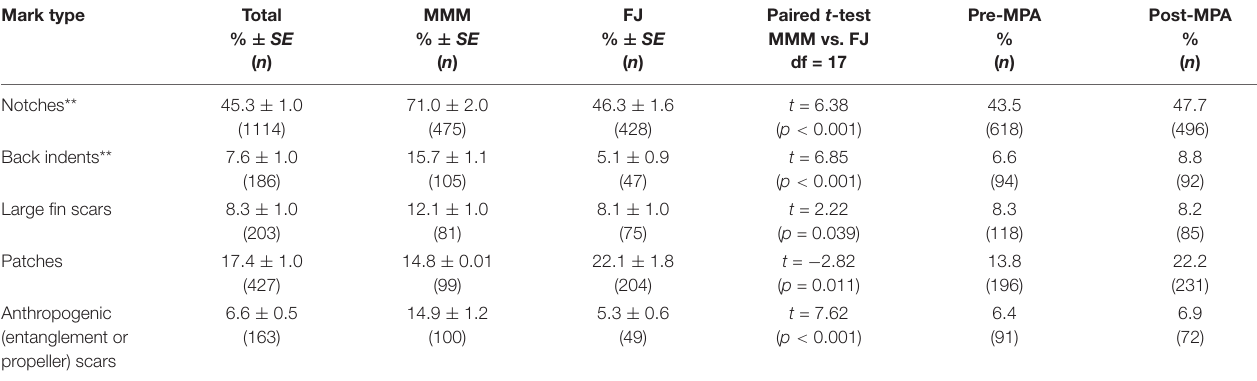
TABLE 3 | Average proportion of marked IDs 1988–2019.